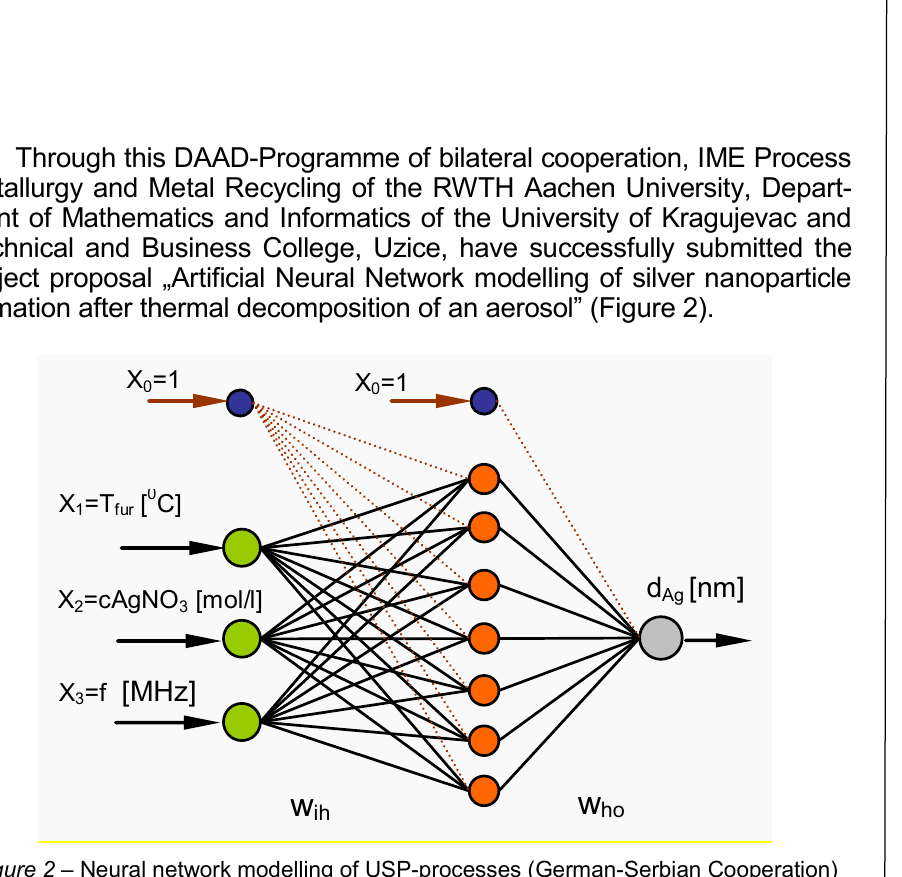
Figure 2 – Neural network modelling of USP-processes (German-Serbian Cooperation) Slika 2 – Modeliranje USP procesa pomo ć u neuronske mreže (nema č ko-srpska